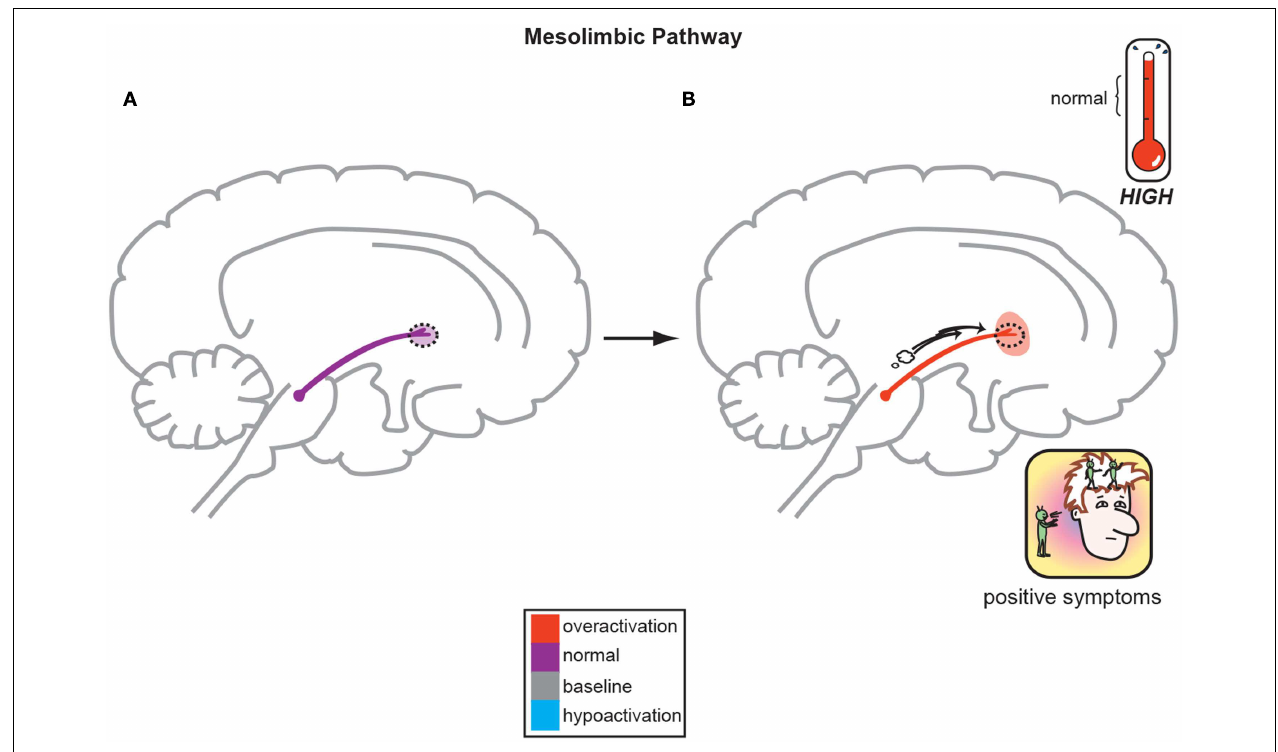
FIGURE 1 |The Dopamine Hypothesis suggests quite simply that normal, baseline mesolimbic dopamine output yields normal psychiatric functioning (A) but the positive symptoms of schizophrenia are a direct